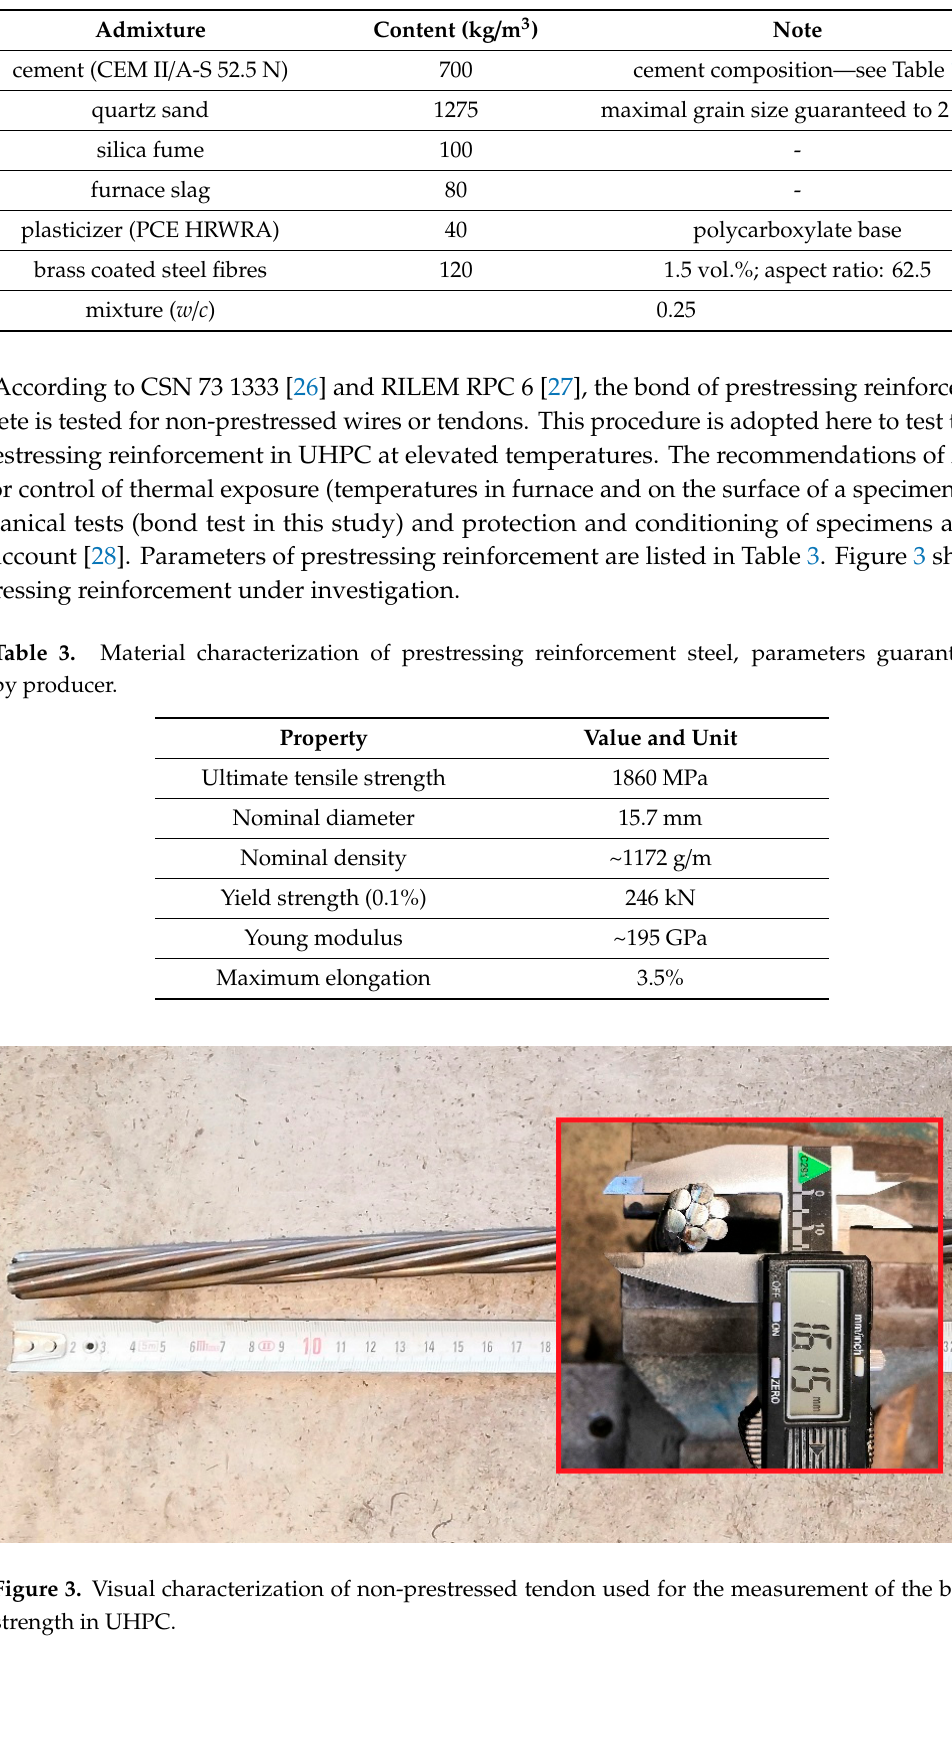
Table 2. Content of UHPC admixtures.